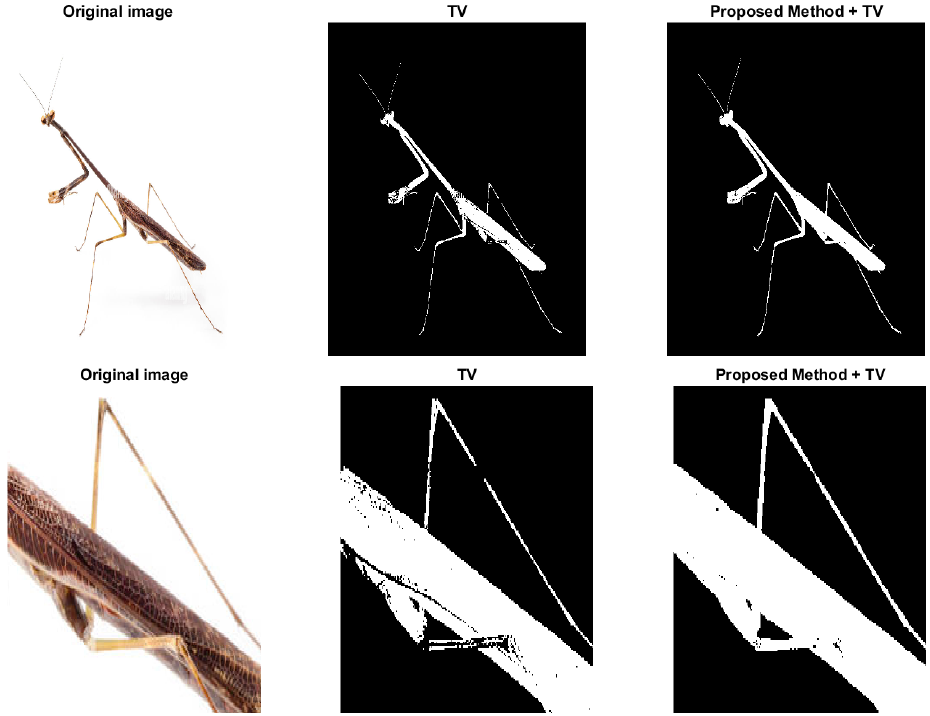
Figure 8. The effect of the proposed regularization on unsupervised model. Column 2: the model in [5] with TV regularization only. Column 3: the proposed model